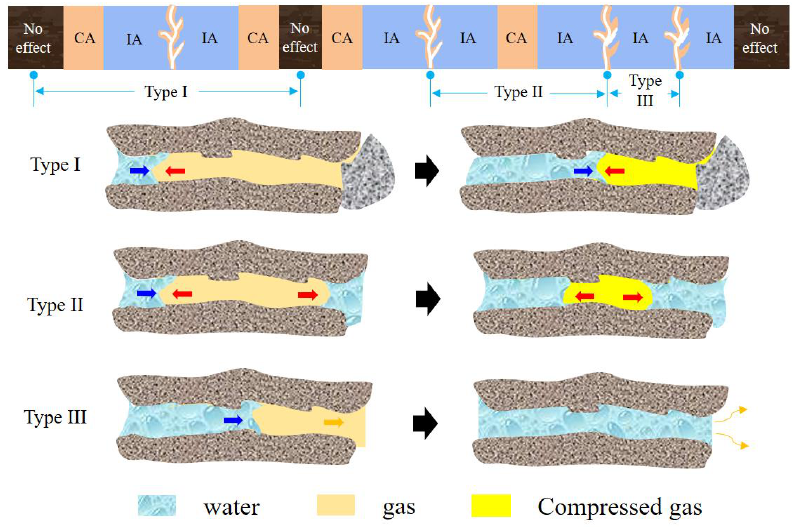
Figure 2. The influence of fracturing fluid imbibition on different types of pores (CA: compressed area, IA: imbibition area).